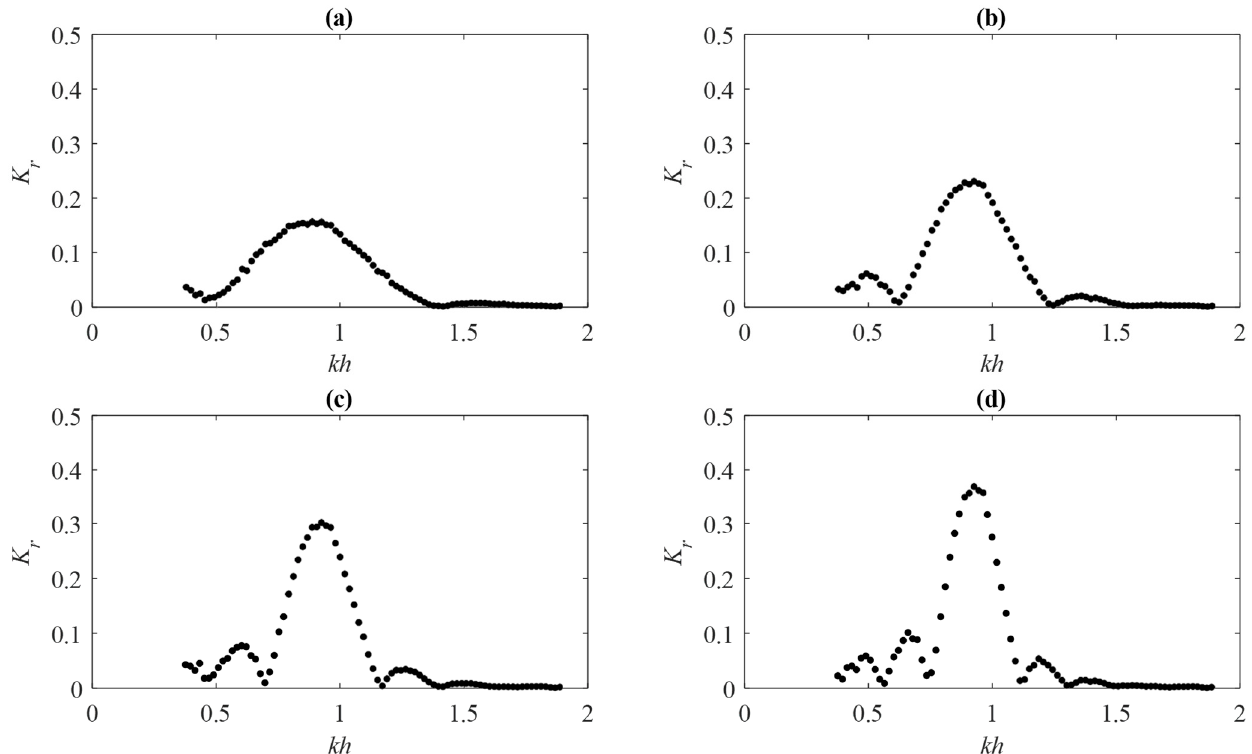
Figure 12. Reflection coefficient of multiple periodically submerged breakwaters with 1.0 m wave- length at 0.3 m water depth: ( a ) N = 2 ( b ) N = 3 ( c ) N = 4 ( d ) N = 5.